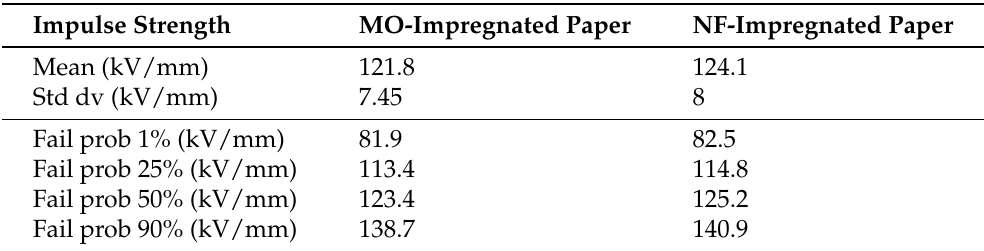
Table 8. Main values obtained from the Weibull fit of the results of the impulse dielectric strength tests for both types of specimens.